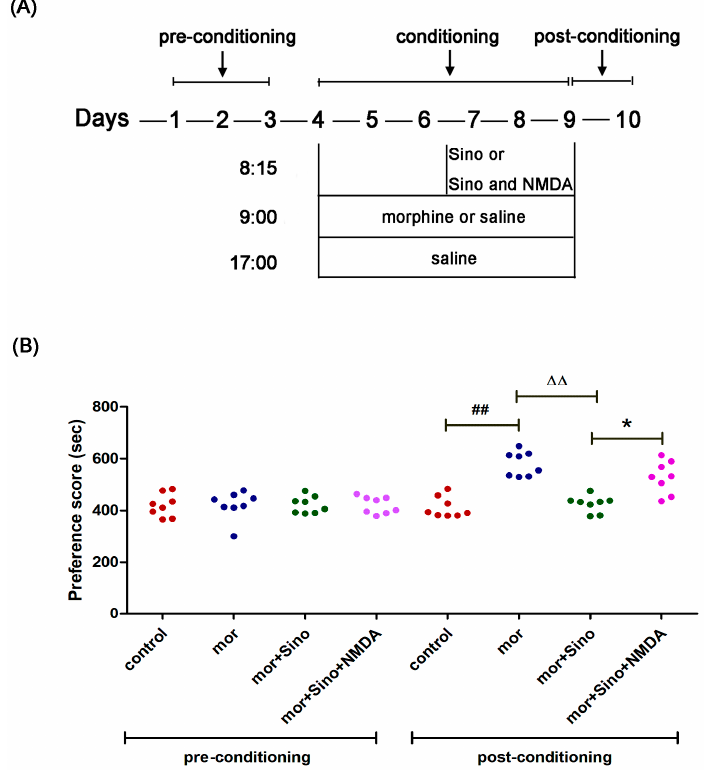
Figure 1. Sinomenine inhibited morphine-induced conditioned place preference in mice. ( A ) Schematic protocol of the conditioned place preference testing; ( B ) The time spent in the white compartment in preconditioning and postconditioning phases ( n = 8). ## p < 0.01 vs. control, ∆∆ p < 0.01 vs.